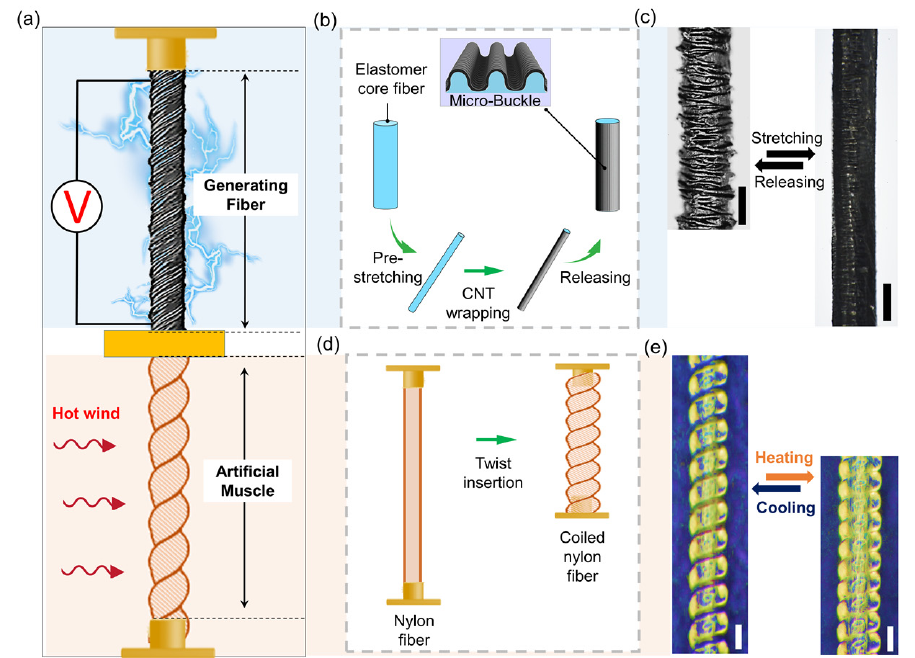
Figure 1. Concept of combined mechano-electrochemical harvesting fiber and thermally responsive artificial muscle: ( a ) schematic diagram of integrated buckled mechano-electrochemical harvesting fiber and coiled artificial muscle structure; ( b ) schematic of fabrication process of mechano-electrochemical harvesting fiber; ( c ) photograph showing elasticity of mechano-electrochemical harvesting fiber (scale bar: 100 µ m); ( d ) schematic of fabrication process of coiled artificial muscle (nylon); ( e ) photograph showing thermally responsive actuation of coiled nylon (scale bar: 100 µ m).